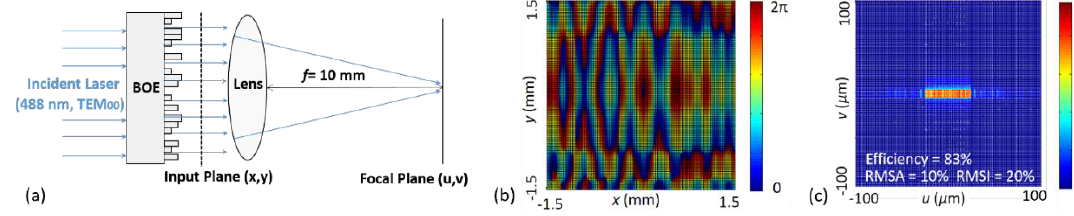
Figure 3. The binary optical element (BOE) for beam shaping and homogenization: ( a ) the illumination system; ( b ) the discretized phase profile of the BOE; ( c ) the intensity distribution on the focal plane.